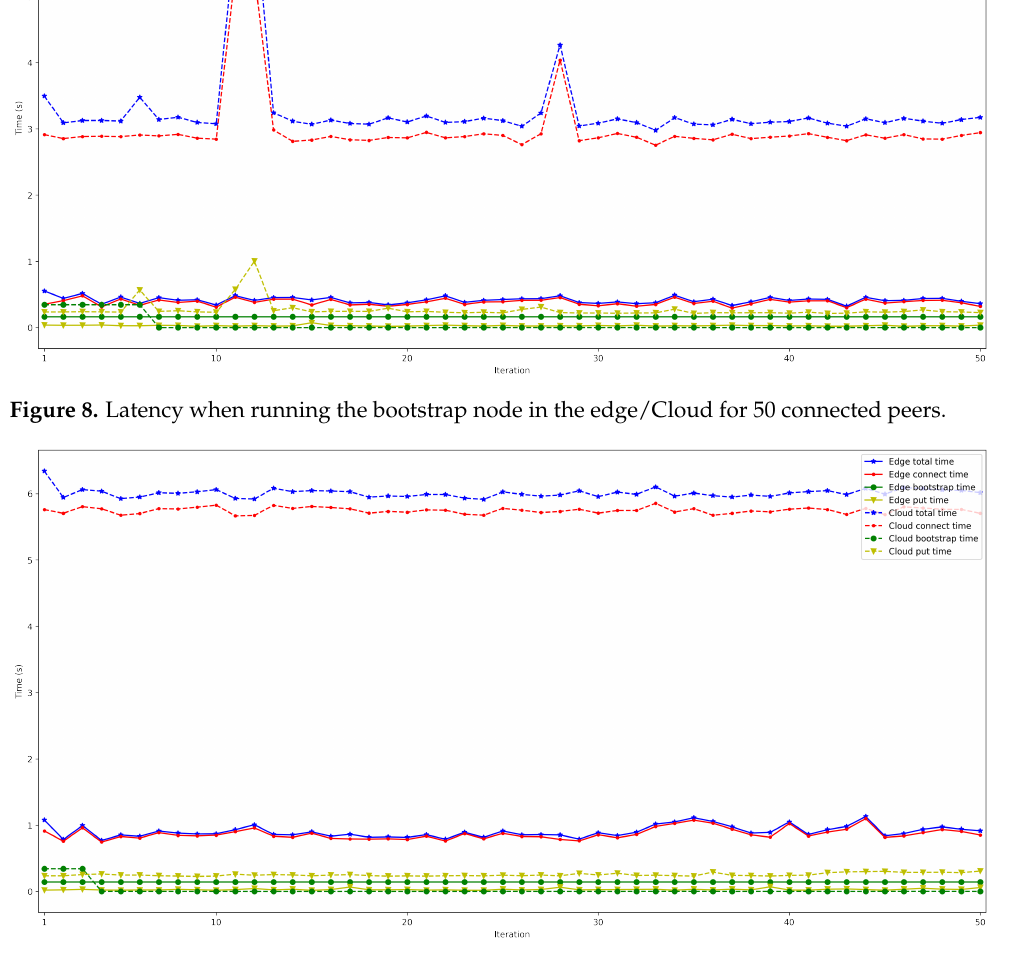
Figure 9. Latency when running the bootstrap node in the edge/Cloud for 100 connected peers.